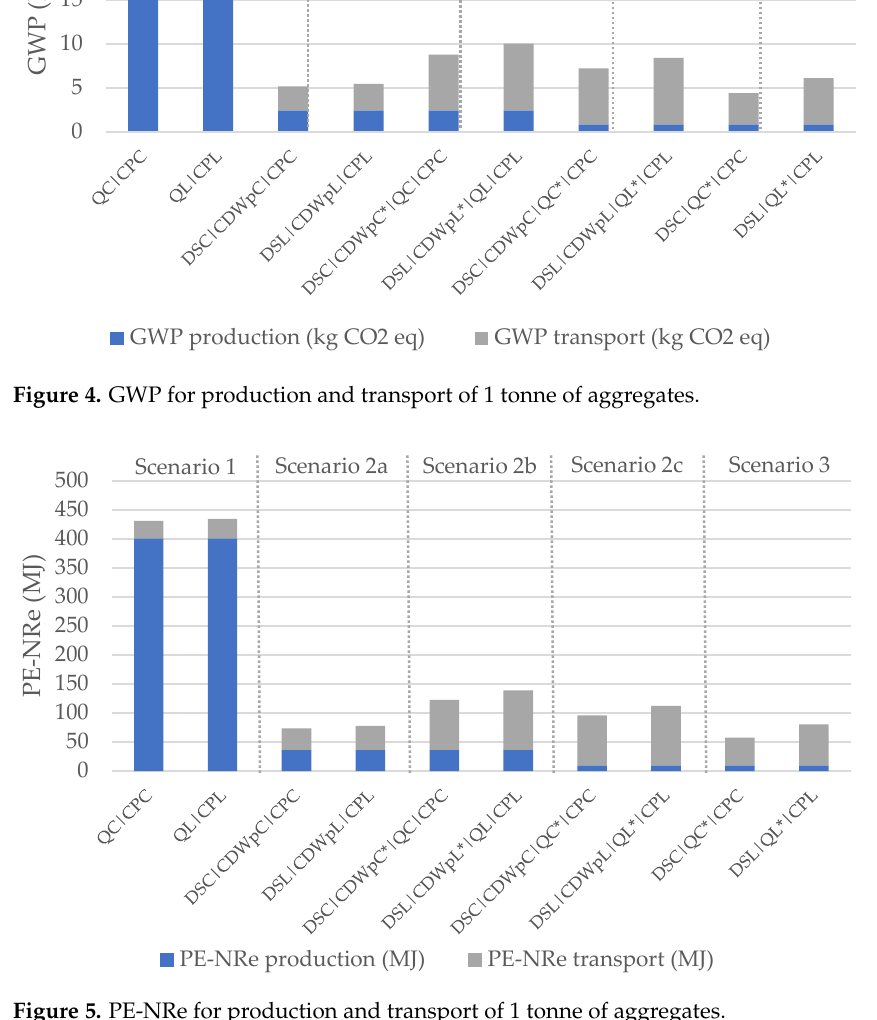
Table 6. Cost for production and transport of 1 tonne of aggregates.